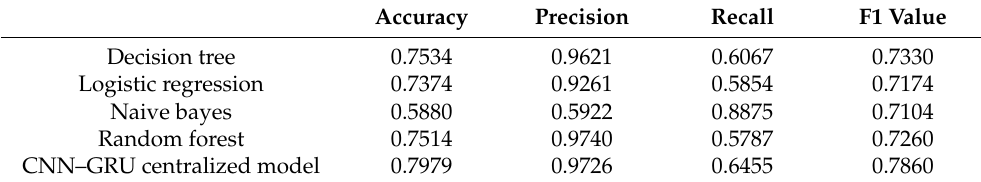
Table 2. Comparison of intrusion detection effects of CNN–GRU centralized model.